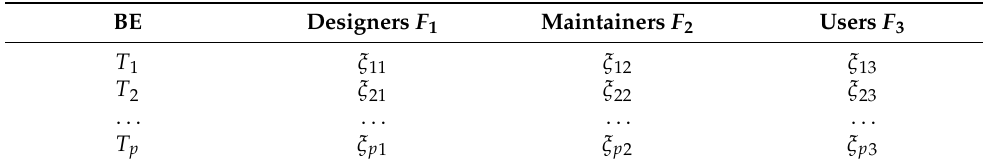
Table 3. Estimation of occurrence given by